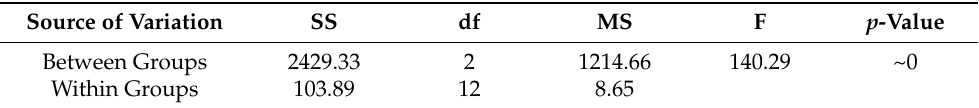
Table 2. ANOVA analysis for the tensile